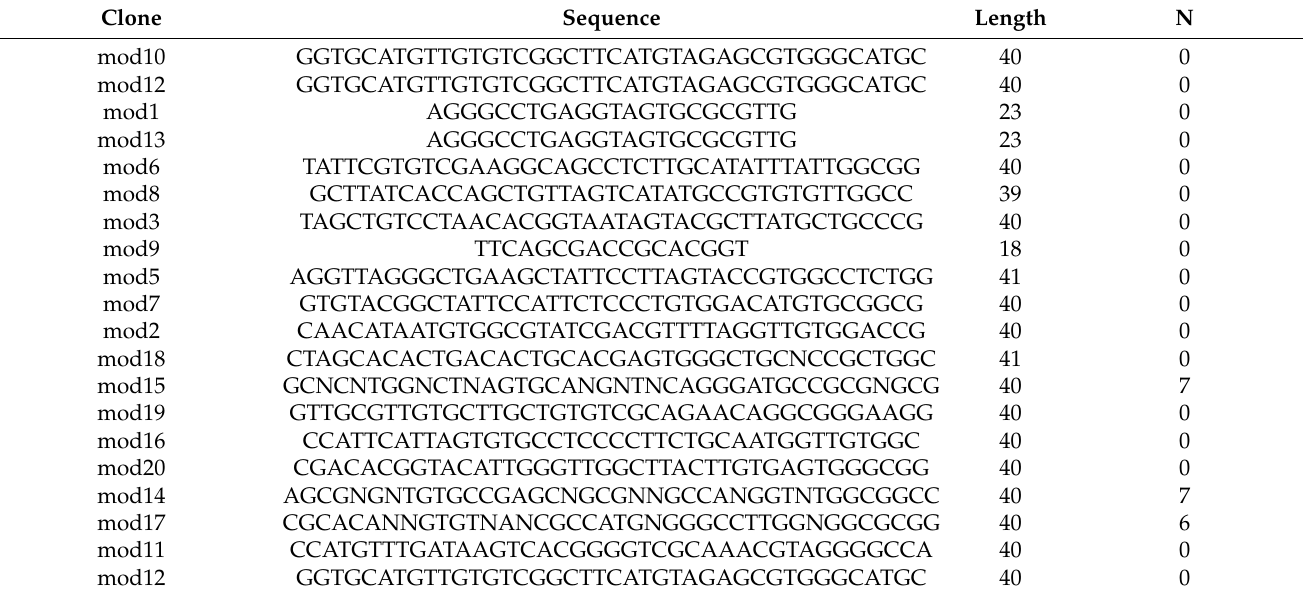
Table A1. Sequences identified in aptamer screening. Mod 1 and Mod 13 sequence was repeated twice (sequence was renamed AIA1) and Mod 10 and Mod 12 sequence was repeated twice (sequence was renamed AIA2); whereas other aptamers were identified once. Length indicates the sequence of the random sequence that was identified in the aptamer. N indicates the number of bases that could not be clearly